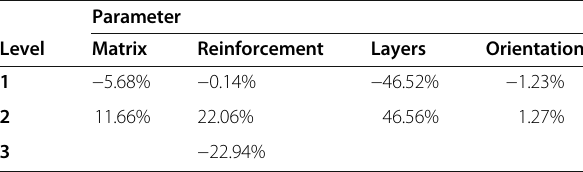
Table 7 The differential mean UTS values (as a % of the global average UTS - dotted line on Fig. 5)